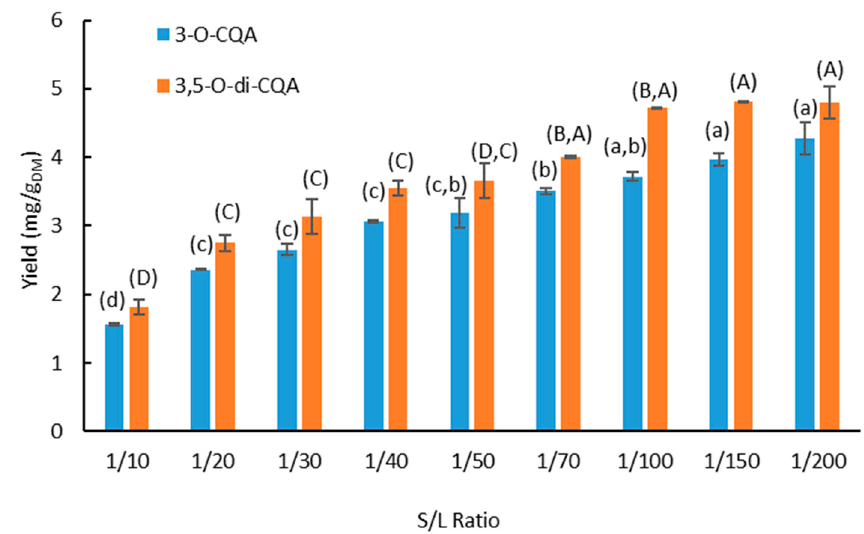
Figure 3. Effect of the solid–liquid ratio on the extraction yield of 3- O -CQA and 3,5- O -di-CQA (T = 30 ◦ C; Solvent = 70% ethanol; t = 24 h). Bars with different small letters indicate significant differences in the yield of 3- O -CQA ( p > 0.05) according to the Tukey test at 95%. Bars with different capital letters indicate significant differences in the yield of 3,5- O -di-CQA.